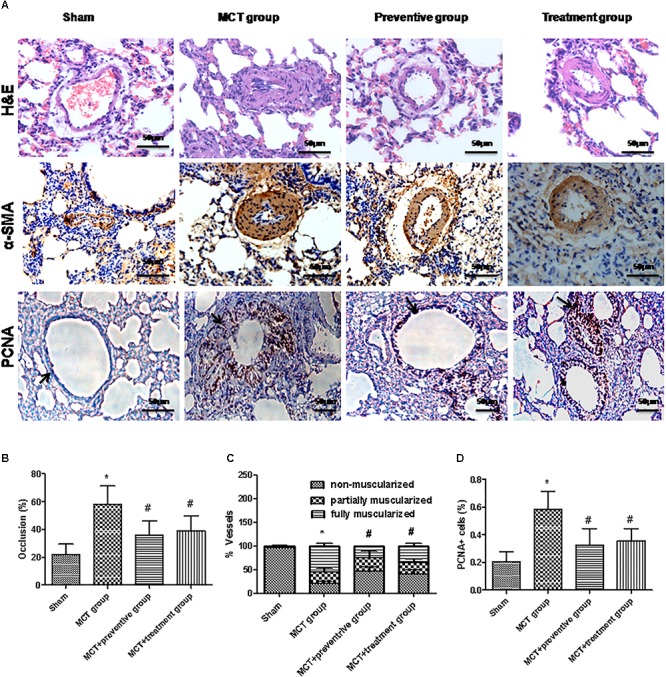
PNU-282987 treatment prevents and reveres pulmonary vascular remodeling. (A) Representative images of hematoxylin and eosin (HE), immunostaining of alpha-smooth muscle actin (α-SMA) and proliferating cell nuclear antigen (PCNA) from the lung in the sham, MCT, prevention and treatment groups. HE shows the thickness of the pulmonary artery. Brown staining with α-SMA indicates pulmonary artery smooth muscle, whereas brown-stained cells with PCNA represent proliferating pulmonary artery smooth muscle. The arrow indicates PCNA positive cells of the pulmonary artery. Occlusion (%), %vessels and PCNA positive cell (%) were calculated in a millimeter from 10 separate images of different fields. Original magnification: x400. (B) Graph showing the percentage of the median thickness of the arteriole. (C) Graph showing percentage of muscularization after α-SMA immunostaining. (D) Graph showing the percentage of PCNA positive cells. The data are summarized as means ± SD. ∗P < 0.05 versus the sham group and #P < 0.05 versus the MCT group. Results shown are from one experiment (sham group, n = 15; MCT group, n = 8; MCT+protective group, n = 13; MCT+treatment group, n = 11).